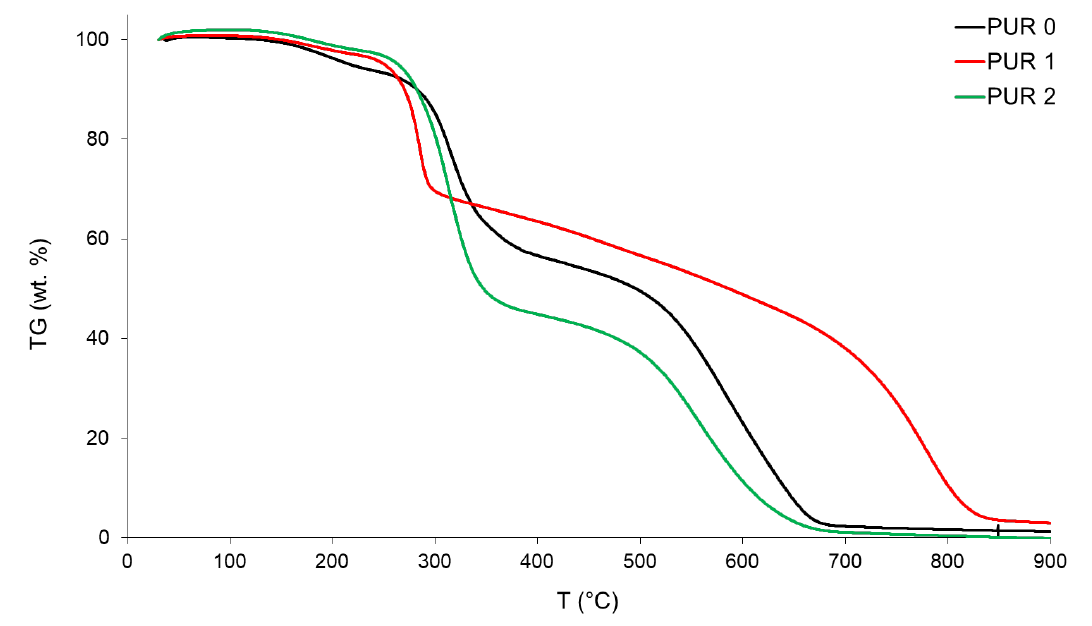
Figure 1. TG curves of the PURs.